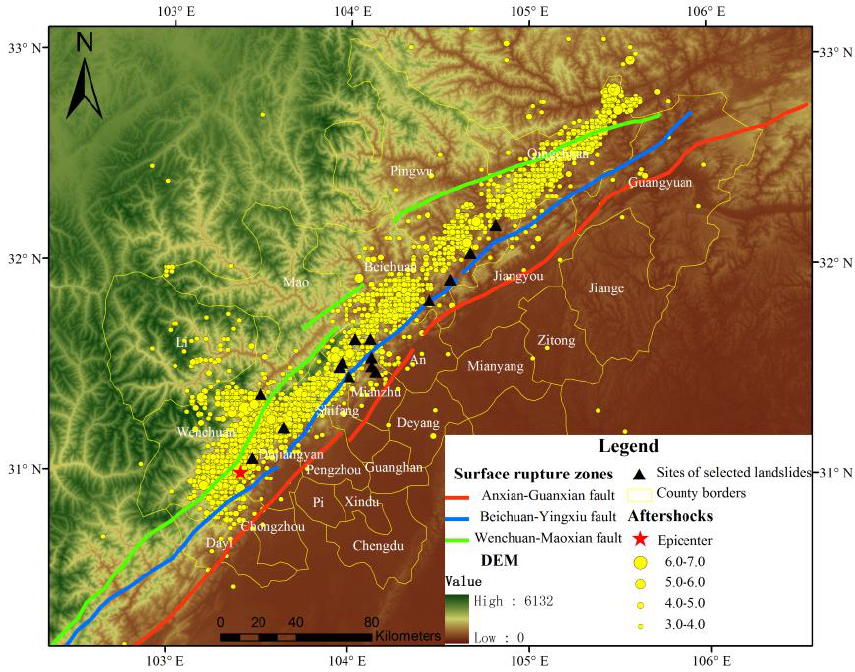
Figure 8. Map of aftershocks (up until 31 December 2008) and surface rupture zones of the Wenchuan earthquake